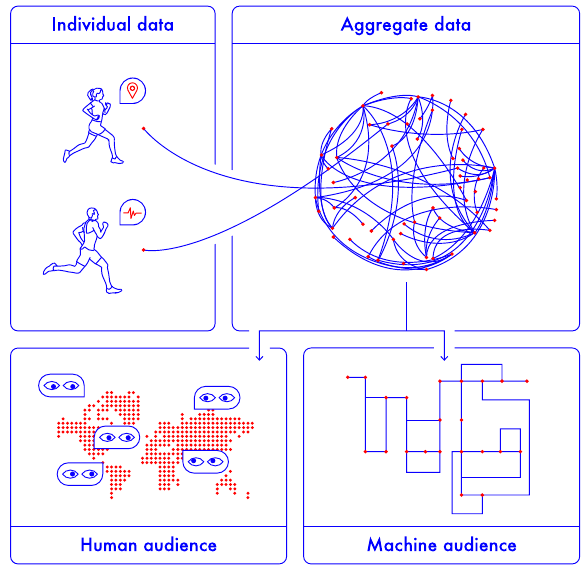
Fig. 1 Data situated for different audiences. Data from individual users of Strava is aggregated and processed for human audiences through data visualisations that are representational, but machine audiences do not need visual representations of the data. Diagram designed for this publication by Maren L. Knutsen at